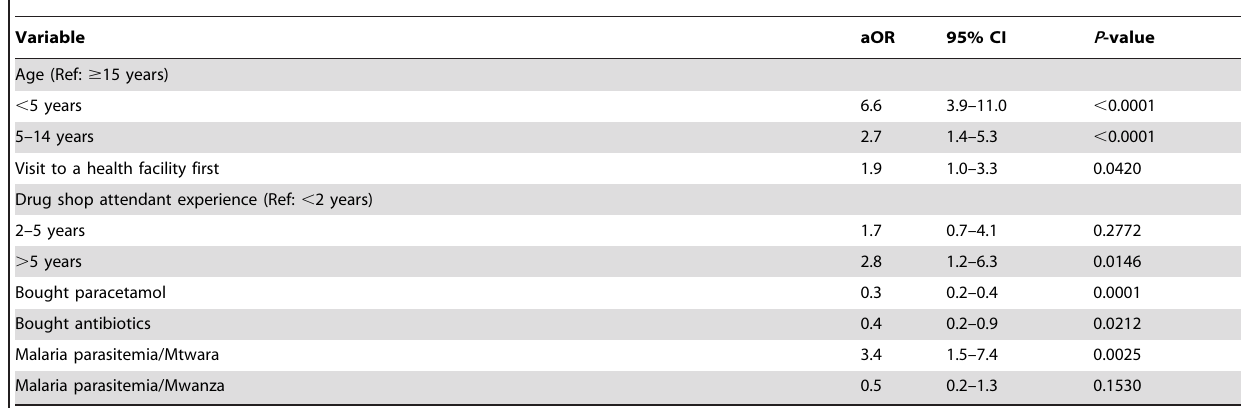
Table 5. Predictors of ACT Purchase